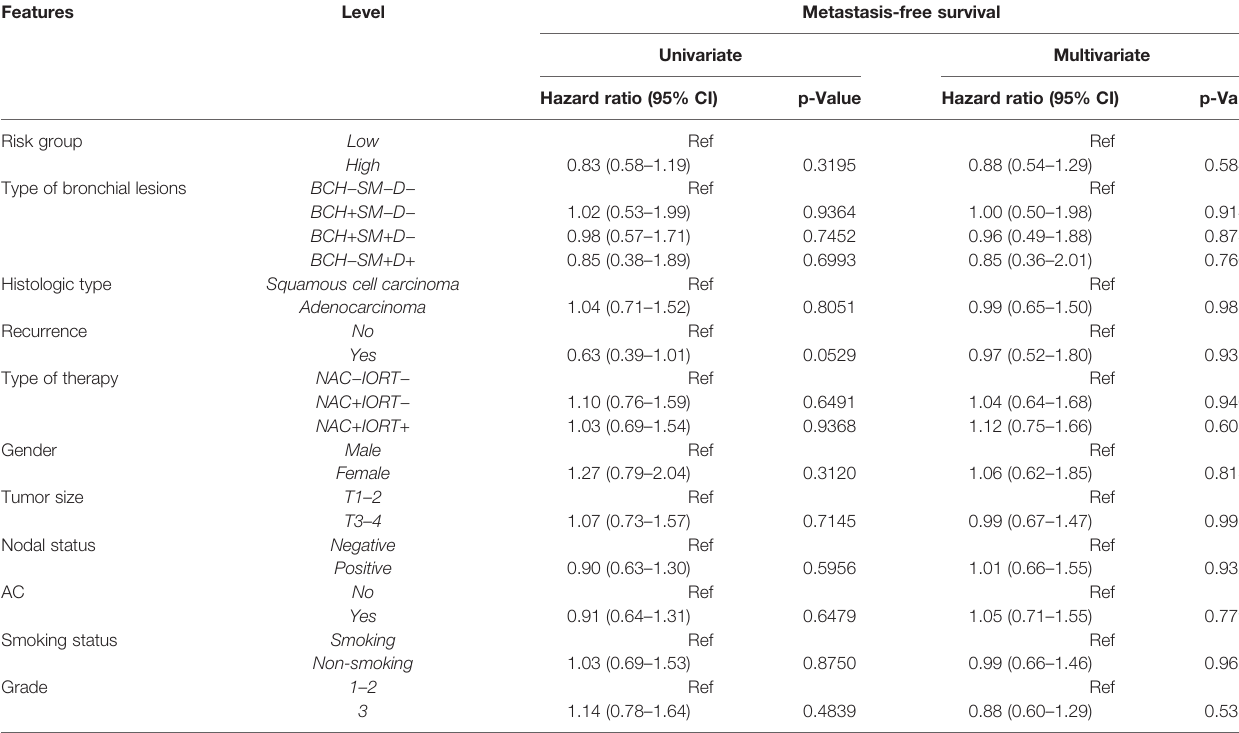
TABLE 5 | Univariate and multivariate Cox regression analyses of prognostic factors for 2-year metastasis-free survival in NSCLC patients.